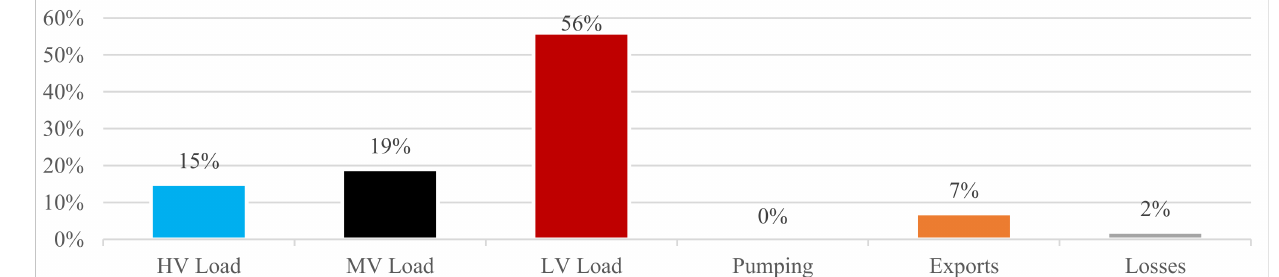
Figure 9. Day-Ahead Market—Buy Volume mix (%), (May 2021), Source: Hellenic Energy Exchange and Authors’ estimations.